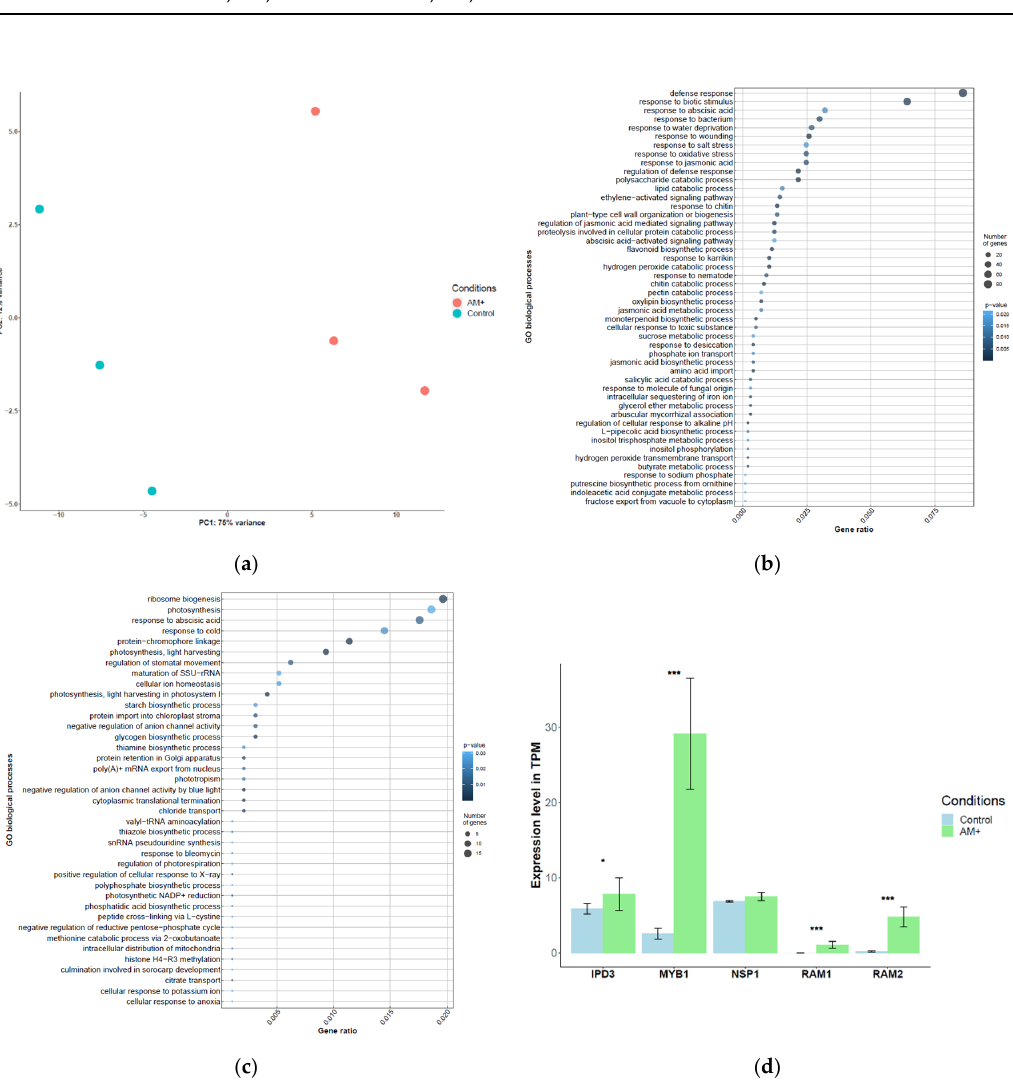
Figure 1. ( a ) Estimation of variance in RNA sequencing data by Principal Component Analysis